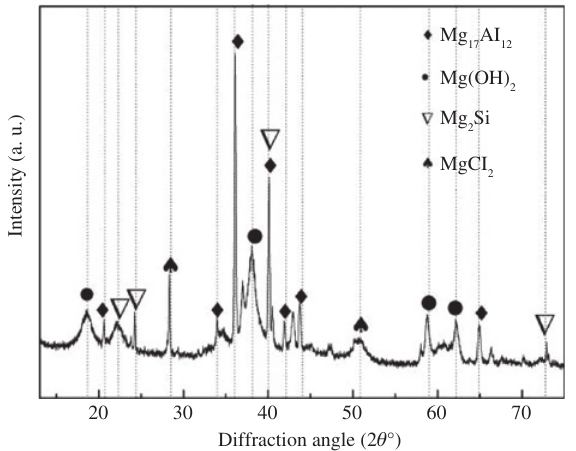
Figure 7: XRD pattern of the degradation product of the FAC/Mg alloy degradable composites in 3 wt.% KCl solution.